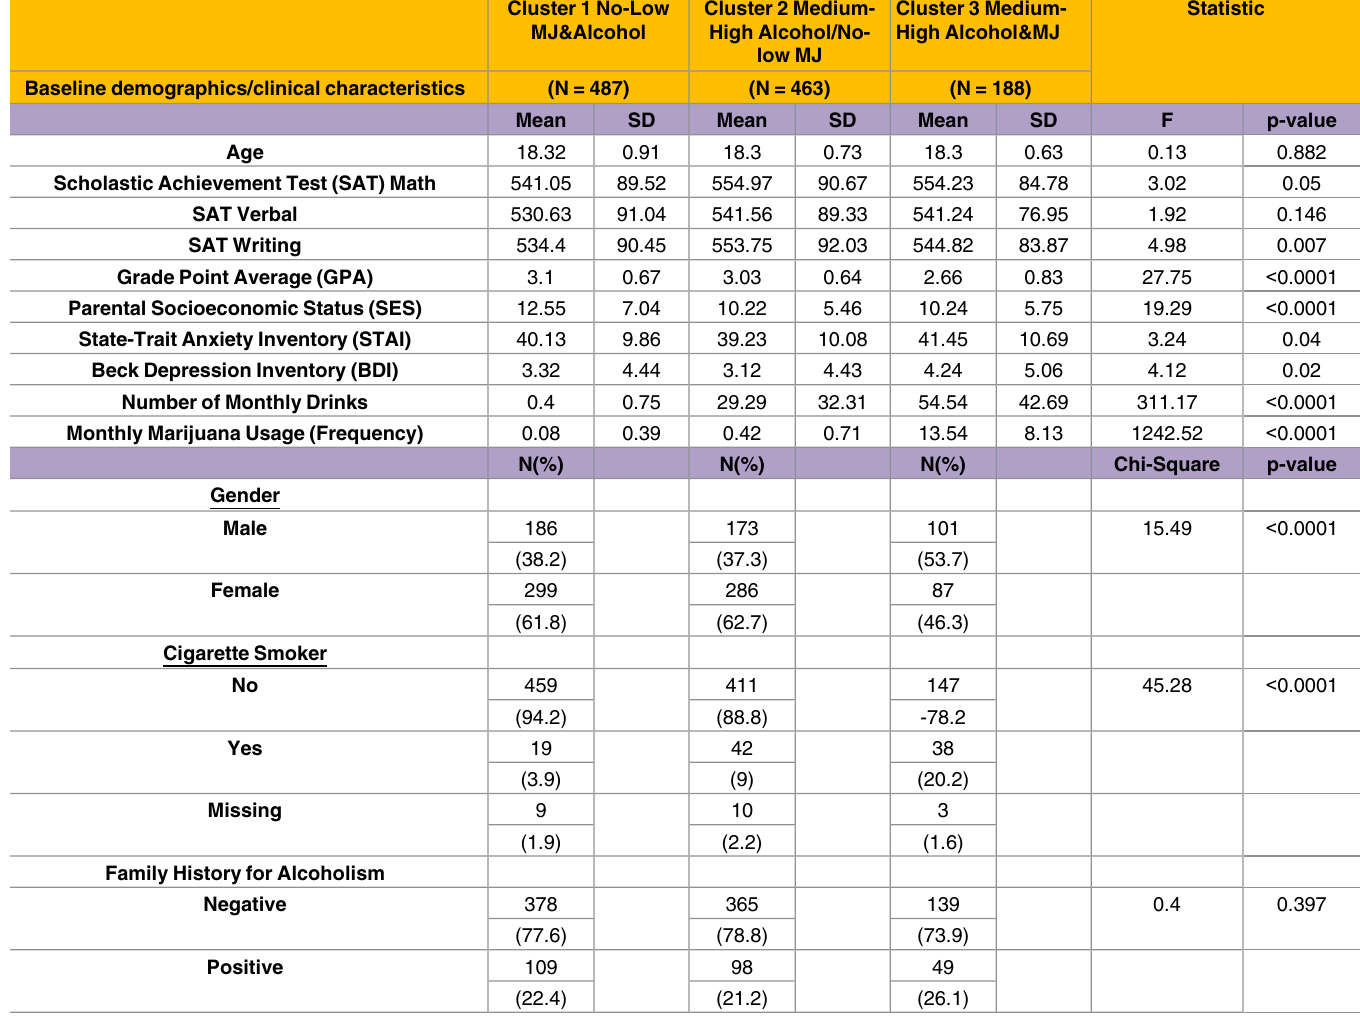
Table 1. Sample demographics. Demographics and clinical characteristics of study participants at semester